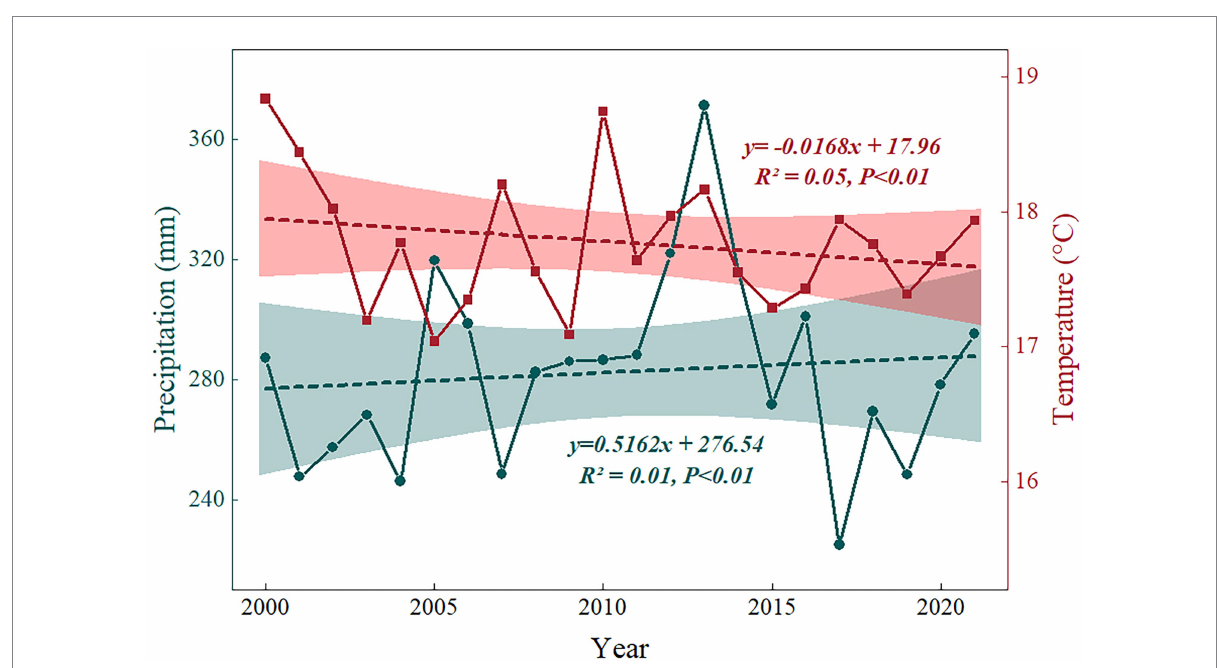
FIGURE 7 Variations of summer mean temperature and precipitation in Northeast China marshes from 2000 to